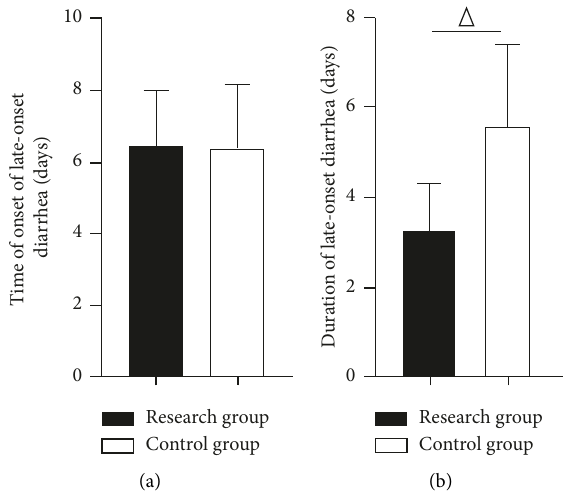
Figure 3: Comparison of time to onset and duration of IIDD for both groups. Note: Δ is the difference between the two groups, P < 0 . 05. (a) Time of onset of late-onset diarrhea (days) and (b) duration of late-onset diarrhea (days).